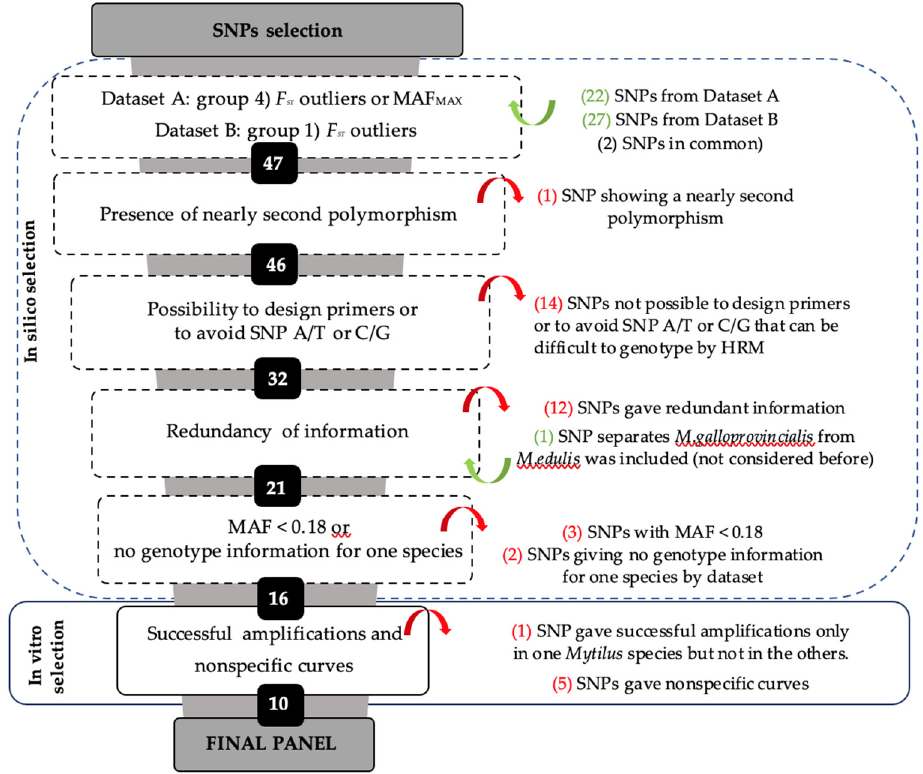
Figure 1. Workflow for the selection of a reduced single nucleotide polymorphism (SNP) panel for species identification in Mytilus genus. Each box represents a stage with the remaining number of SNPs. Filtering criteria were summarized on the right side of each stage. In green is the number of loci added; in red is the number of loci removed. Minor allele frequency (MAF).